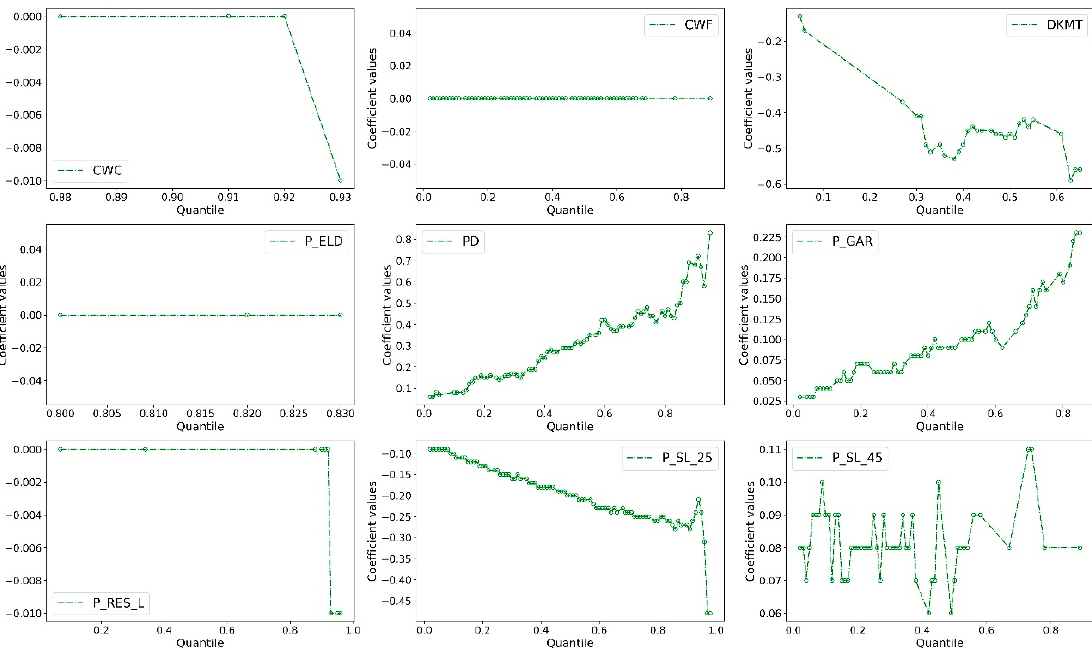
Figure 5. Coefficient estimates in SARQ model with fatal-plus-injury crash rate as the dependent variable.